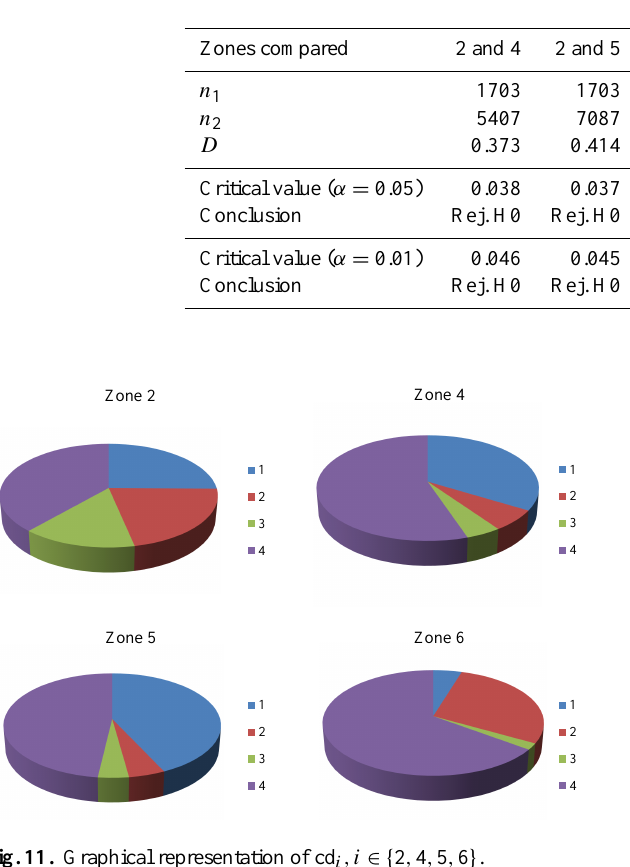
Figure 11. Graphical representation of cd i , i ˛ {2, 4, 5, 6}. 7